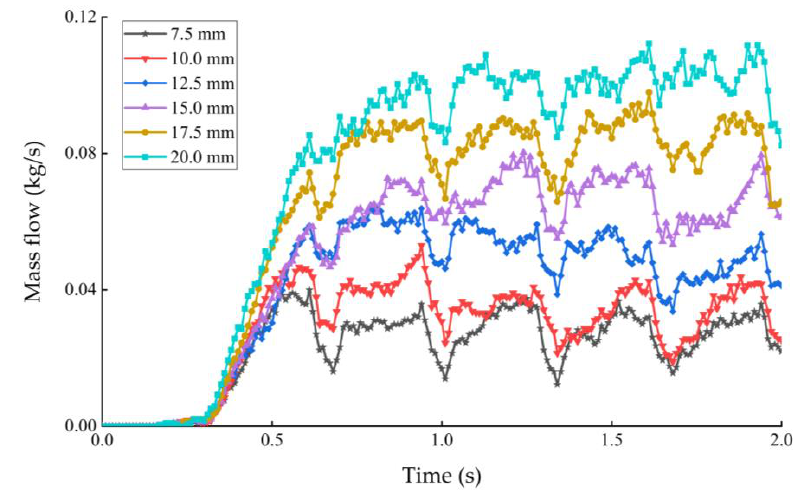
Figure 13. Grain mass flow rate under different deflector gaps.